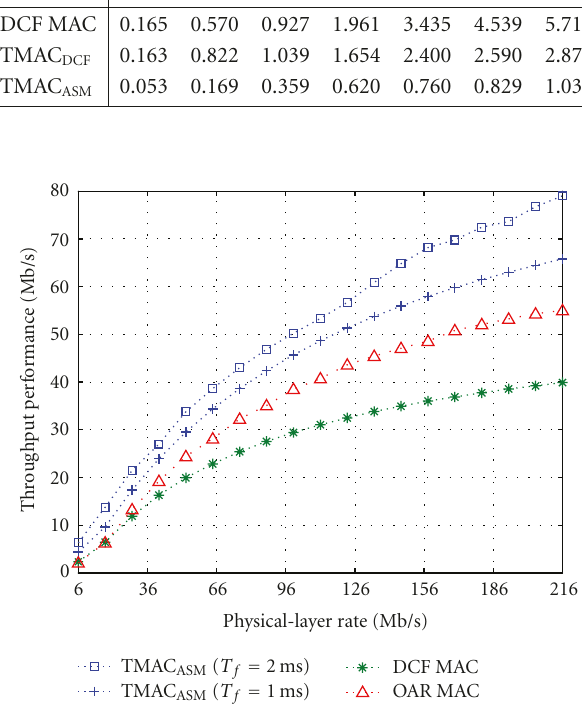
Figure 5: Network throughput versus physical-layer data